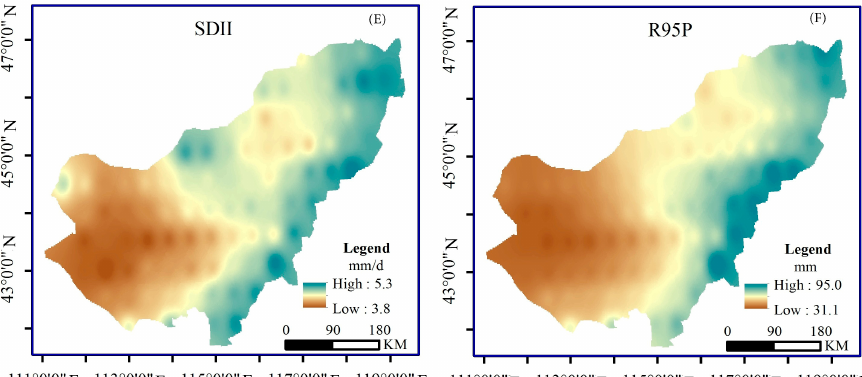
Figure 4. Spatial distribution of the average extreme indices: ( A ) consecutive dry days (CDD); ( B ) consecutive wet days (CWD); ( C ) number of days with daily precipitation ≥ 10 mm per year (RR10); ( D maximum precipitation over five days (RX5DAY); ( E ) precipitation intensity (SDII); and, ( F ) precipitation higher than the threshold of 95% in one year (R95P).